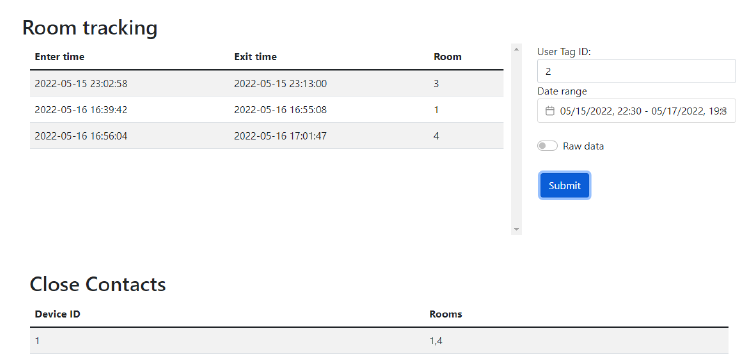
Figure 8. BLE system web interface displaying the information found on the database for tag 2 in the displayed time range. This information includes the rooms enterance and exit times as well as the close contacts that were in the same rooms at the same time.